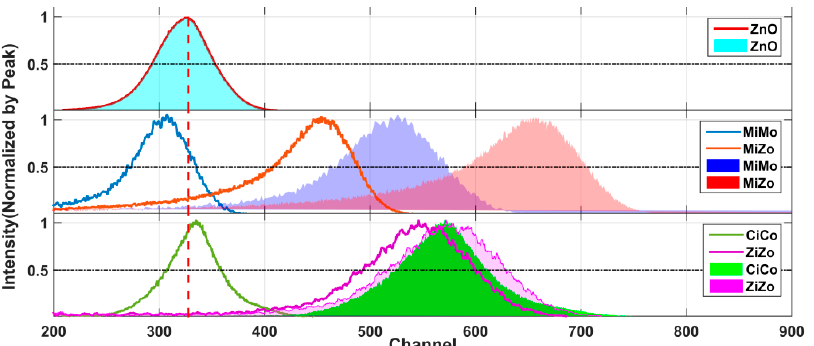
Figure 5. Energy spectra of various samples excited by α particles before and after deducing the spectral response.